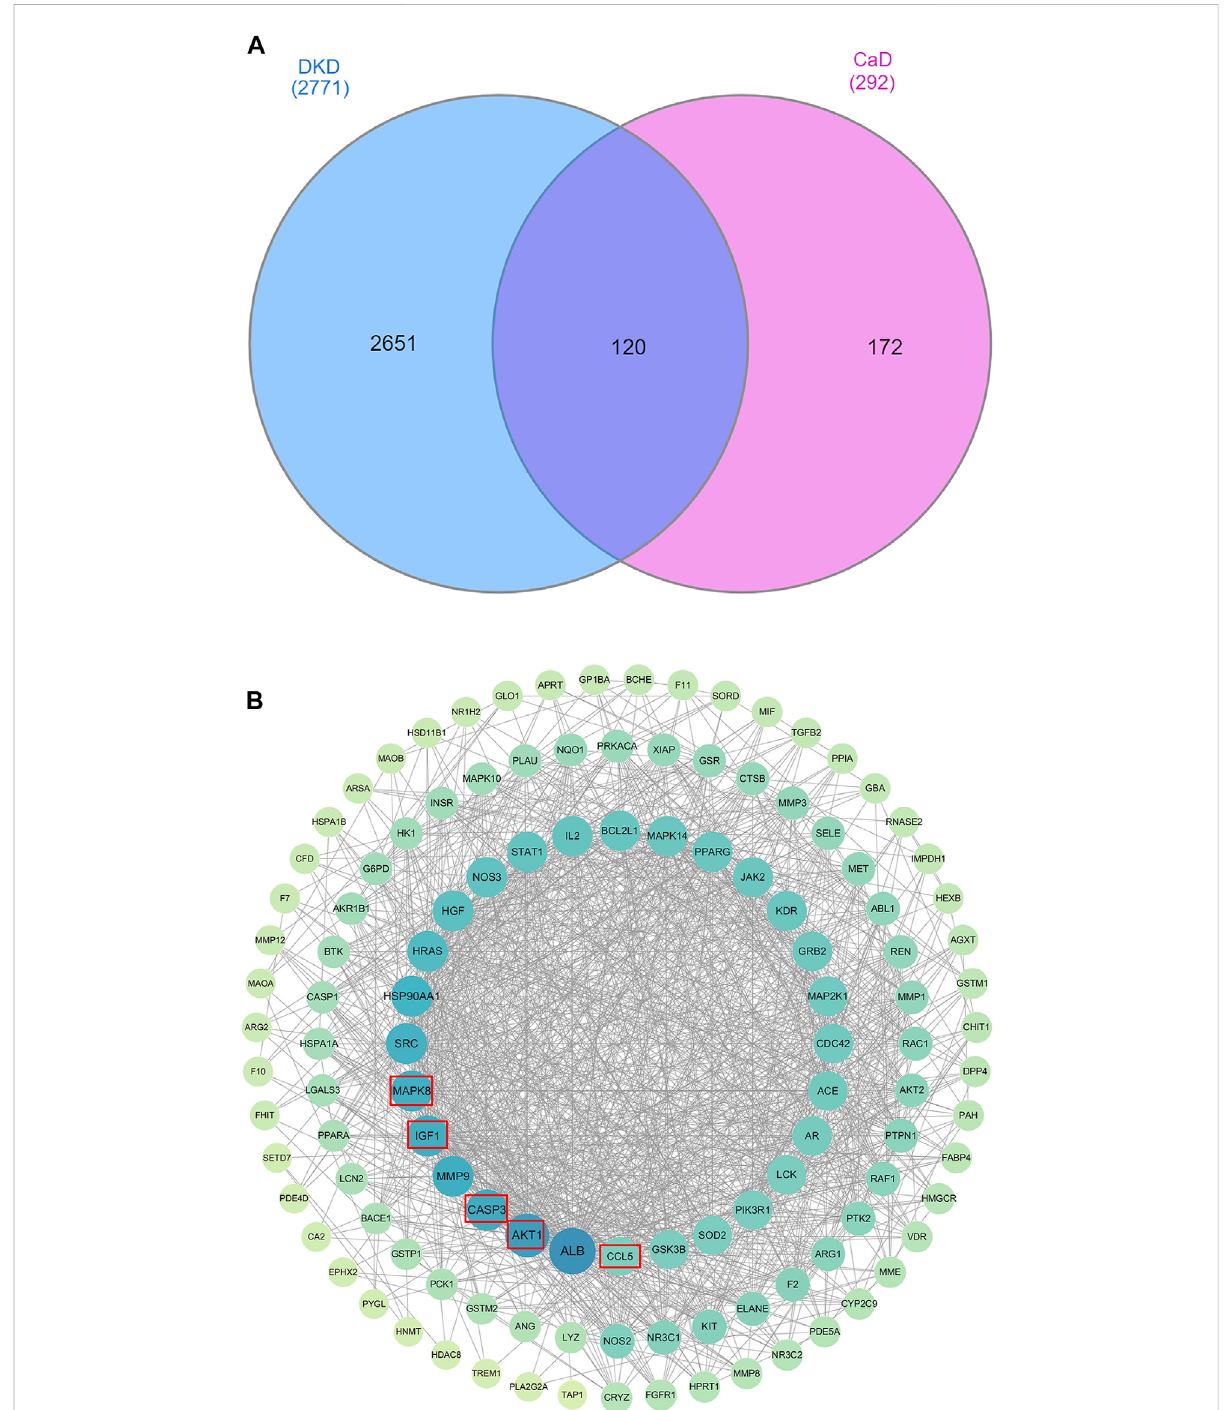
FIGURE 3 Venn diagram and PPI work. (A) Venn diagram. The blue section indicates DKD-related targets, and the pink section indicates CaD-related targets.Twenty- fi vetargetsinthemiddleoverlappingsectionarecommontargetsofDKDandCaD. (B) PPInetwork.Atotalof119targetproteinsand 1,175 interacting edges are present in the network. Sizes and colors of the nodes are illustrated from big to small and blue to green in a descending order of degree